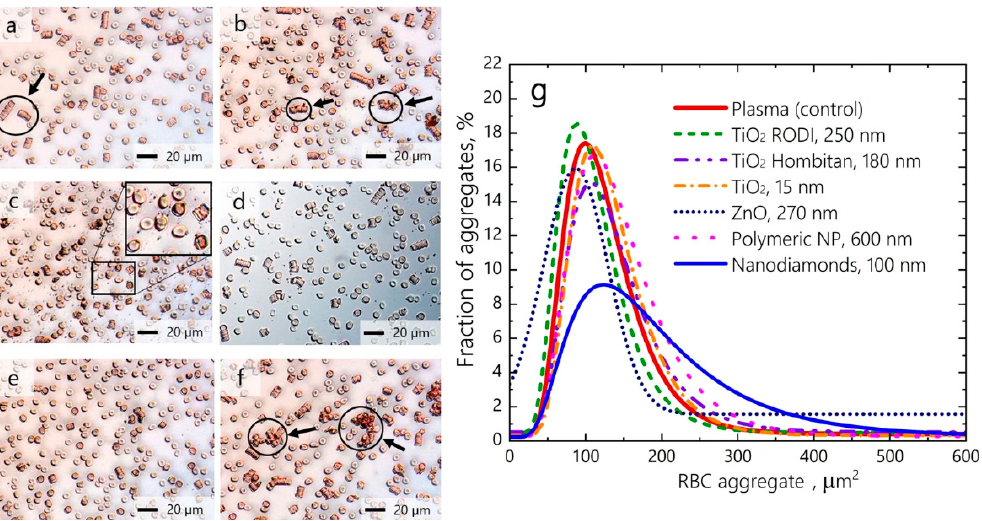
Figure 1. Relative size distribution of erythrocyte aggregates observed by conventional optical microscopy under the influence of ( a ) polymeric NPs 600 nm; ( b ) TiO 2 NPs 250 nm; ( c ) TiO 2 NPs 180 nm; ( d ) TiO 2 NPs 15 nm; ( e ) ZnO NPs 270 nm; and ( f ) nanodiamonds 100 nm. ( g ) Distribution of erythrocyte aggregates by occupied area based on the quantitative assessment of images in ( a – f ) (adapted with permission [32]).